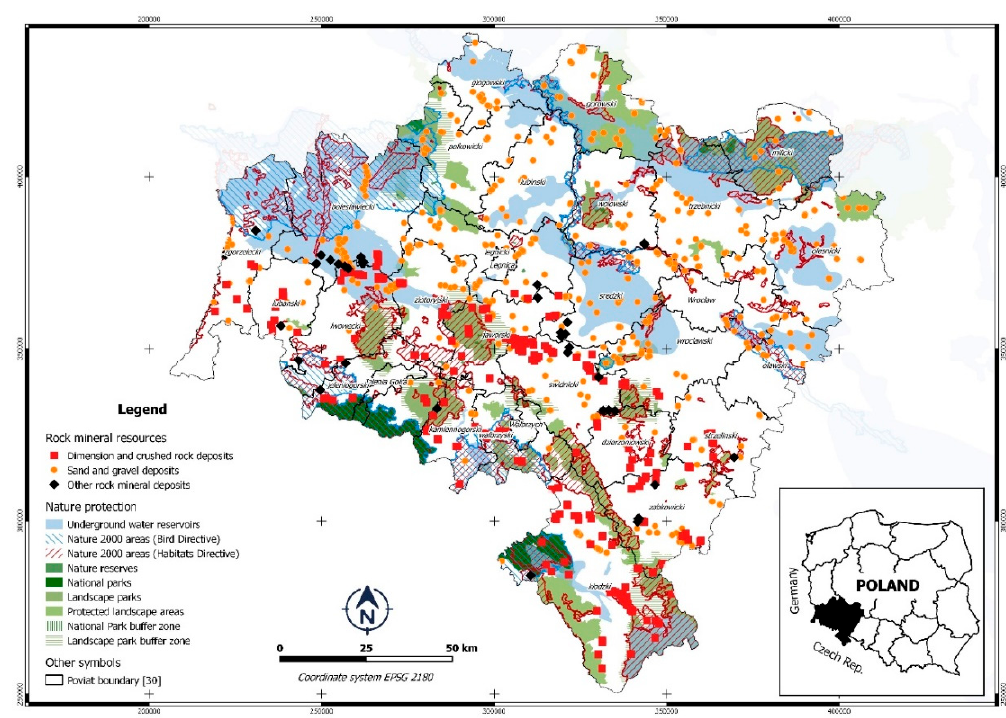
Figure 1. Location of deposits of rock raw materials against the background of protected areas and Main Underground Water Reservoirs in the Lower Silesia Province.